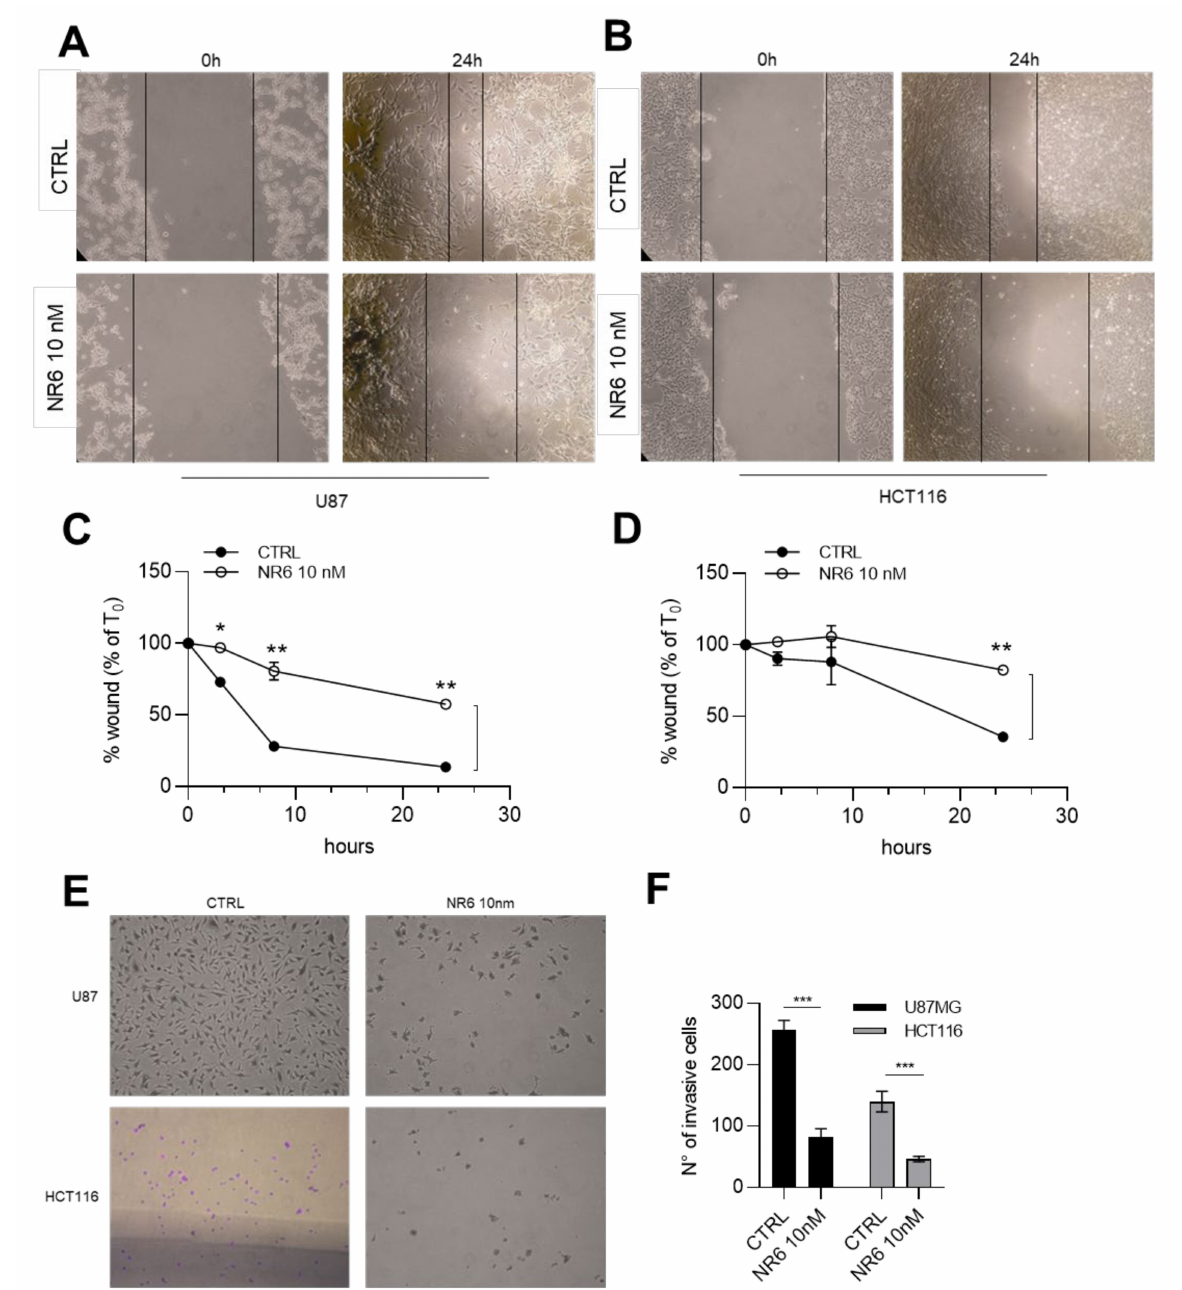
Figure 6. ALDH1A3 inhibitor is able to reduce migration and invasiveness in vitro. ( A ) Representative wound healing images of U87MG cells treated with vehicle and NR6 10 nM. ( B ) Representative wound healing images of HCT116 cells treated with vehicle and NR6 10 nM. ( C ) Percentage of U87MG wound closure (compared to % of the control) after 24 h of treatment. ( D ) Percentage of HCT116 wound closure (compared to % of the control) after 24 h of treatment. ( E ) Representative images of invasive assay of U87MG and HCT116 cells treated with the control and NR6 10 nM. ( F ) Number of invasive cells. Two replicates of n = 4 independent experiments. (*** p < 0.001, ** p < 0.01, * p < 0.05 by unpaired two- tailed t